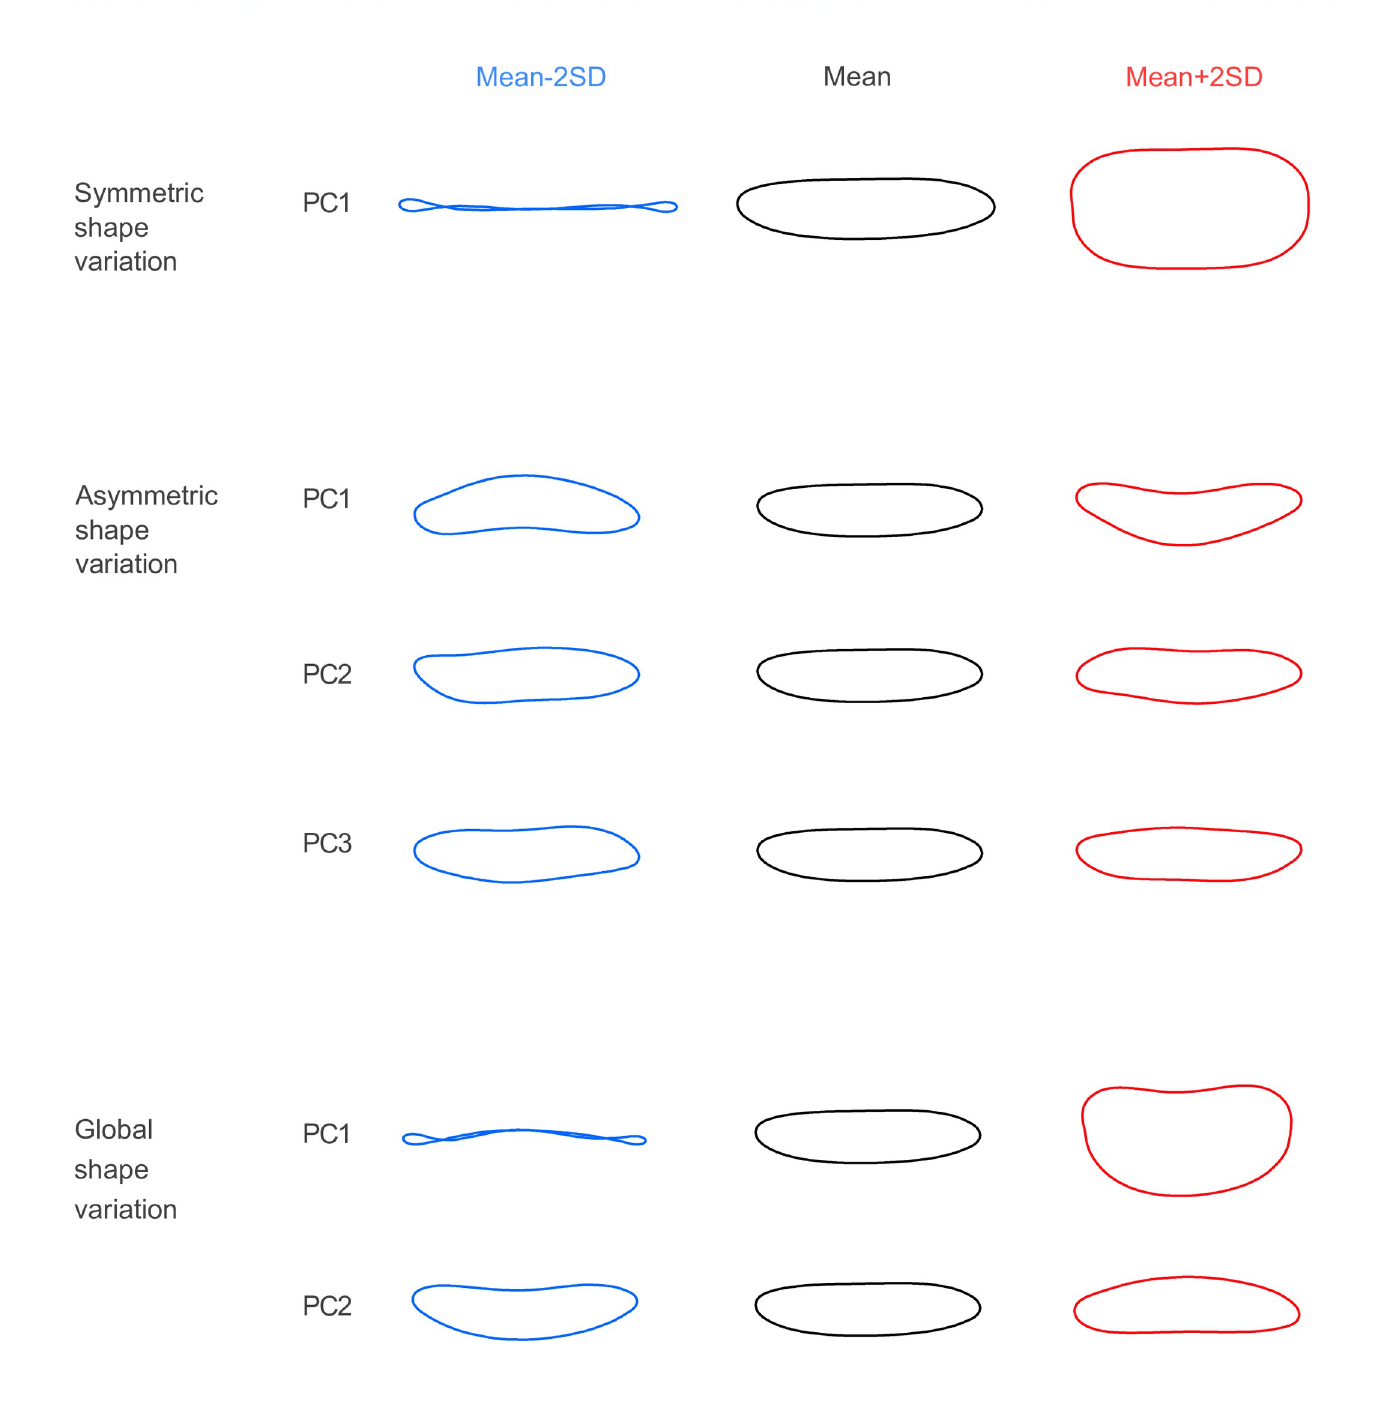
Fig 4. Symmetric shape variation reflects spore thickness while asymmetric–different aspects of curvature. The figure shows ranges of shape variation (mean plus and minus two times the standard deviation, SD) that separate principal components (PC) account for.